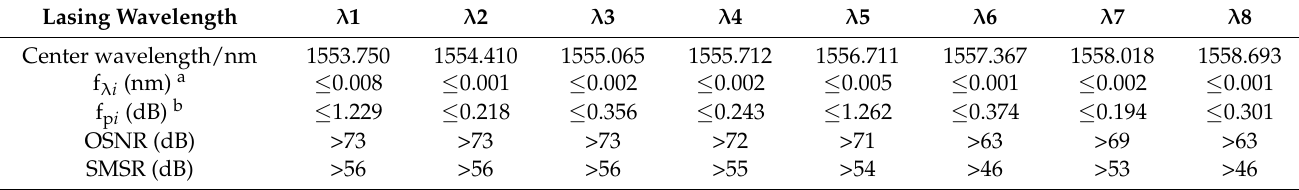
Figure 3. ( a ) 8WS-EDFL laser output spectra of the single-wavelength-switchable operations mea- sured by OSA. ( b ) Spectral stability of the λ 2 lasing. Table 1. Performance parameters of the single-wavelength lasing switchable